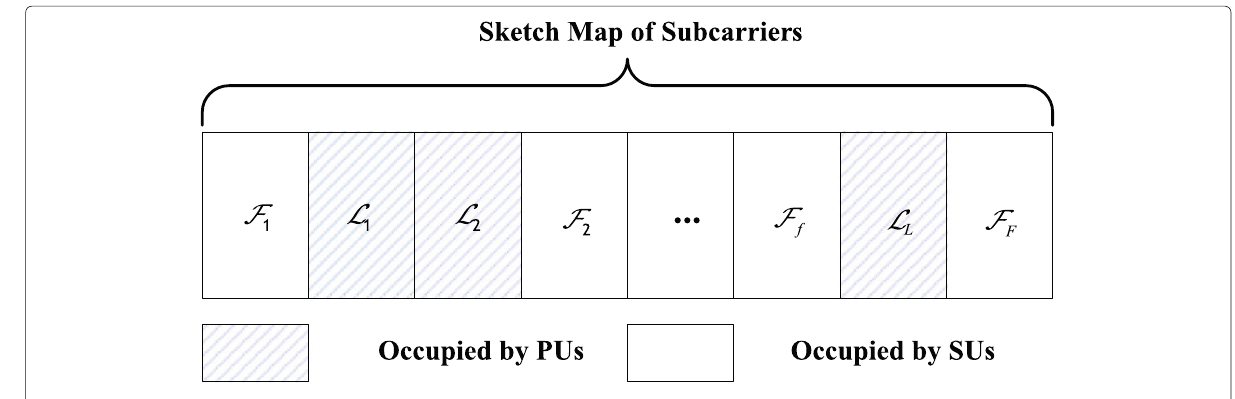
Fig. 2 The diagram of subcarriers. The ones filled with slash are occupied by PUs and the others can be allocated to